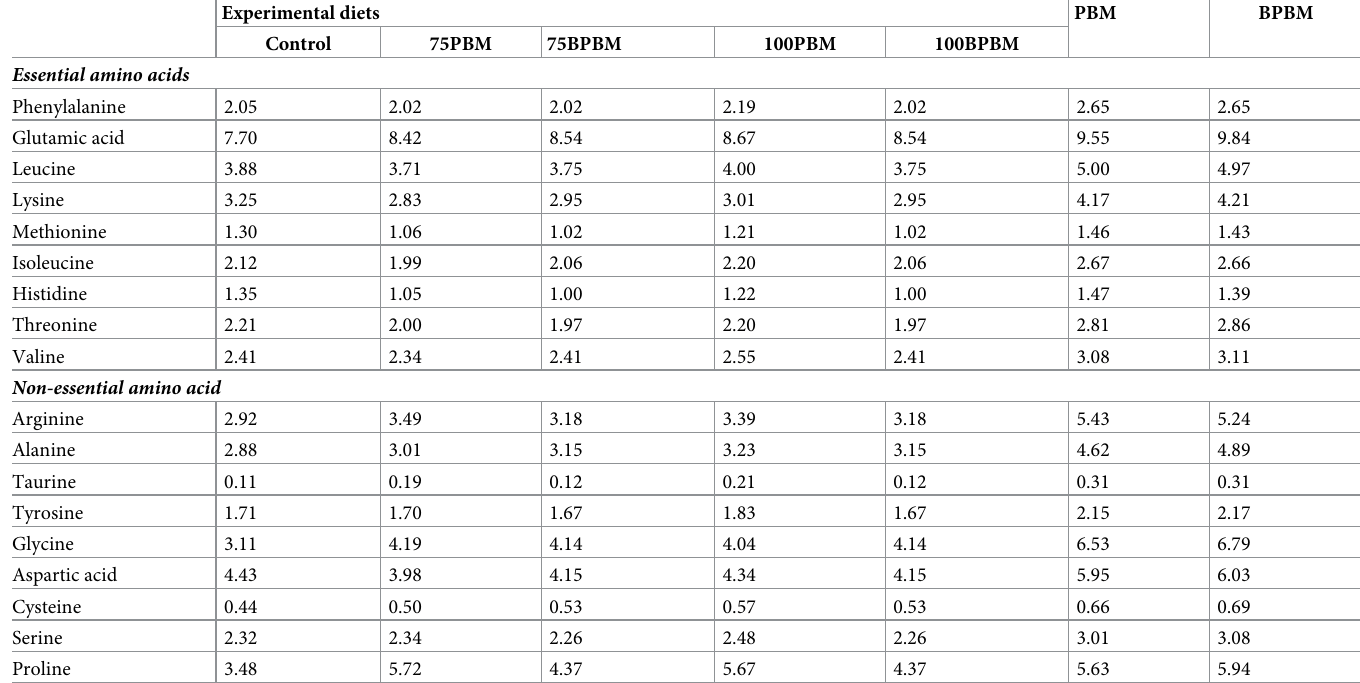
Table 2. The amino acid composition (g/100g) of the five experimental diets and tested unprocessed and bioprocessed PBM. Experimental